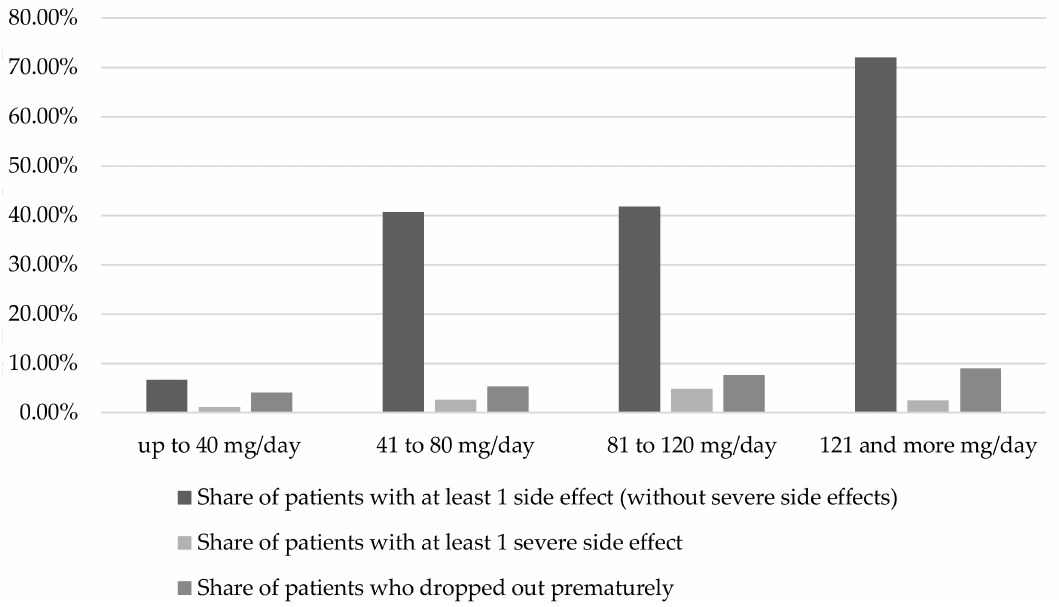
Figure 3. Occurrence of adverse events in dependence on febuxostat dosage (n (up to 40 mg/day) = 1803; n (41 to 80 mg/day) = 2361; n (81 to 120 mg/day) = 673; n (121 and more mg/day) = 200; for each dose group differentiation between: patients with at least one side effect (column 1), patients with at least one severe side effect (column 2), patients who dropped out prematurely (column 3); daily dose used in mg/day for each dose group: up to 40 mg/day: 10, 20, 30, 40; 41 to 80 mg/day: 50, 60, 70, 80; 81 to 120 mg/day: 90, 120; 121 mg/day and more: 160, 180, 240)